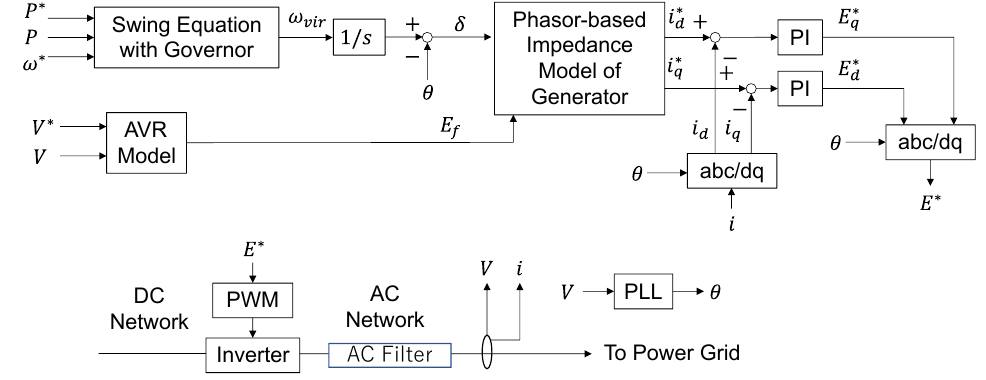
Figure 3. Control scheme of the VSM algorithm.